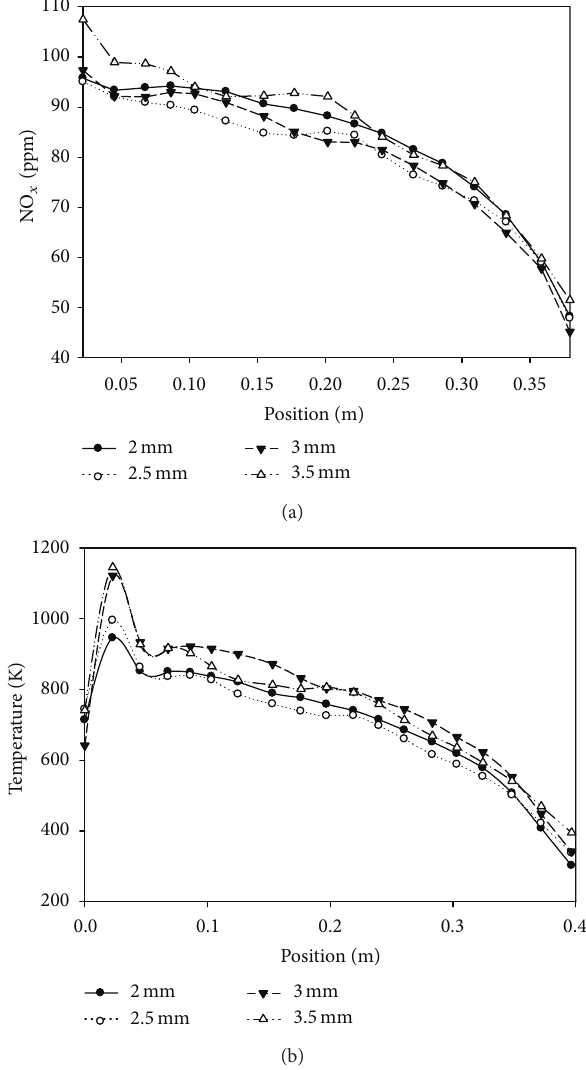
Figure 9: Effect of variations of fuel diameter on central (a) NO 𝑥 profile and (b) temperature